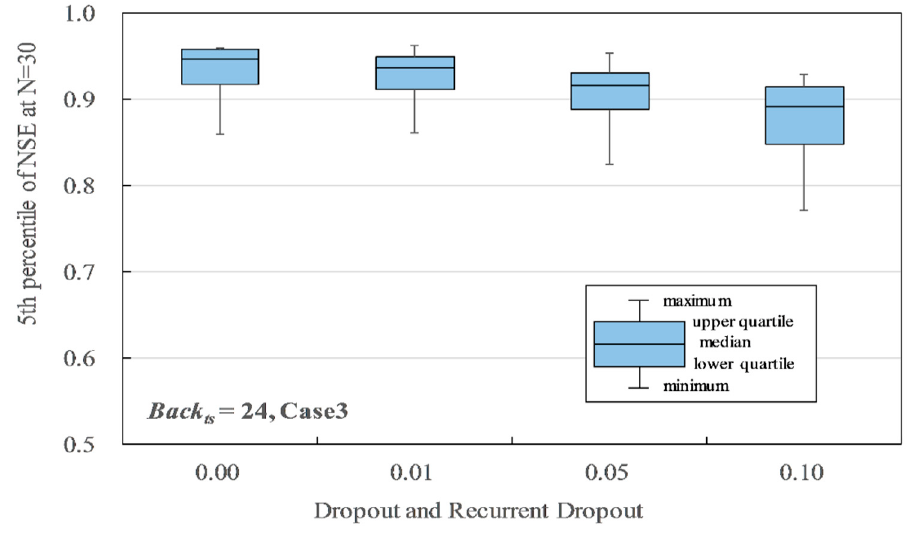
12 of 16 Figure 12. Influence of precipitation on the estimation results. 3.4. Dropout and Recurrent Dropout Figure 13 shows the influence of dropout and recurrent dropout ( Drp & Drp r ), when Hid = 20 to 200 and Back ts = 24 for Case 3. The accuracy improved as Drp & Drp r became smaller, and Drp & Drp r = 0.00 had the best accuracy of 0.917 in the lower quartile P 5 of the NSE. The maximum P 5 of the NSE was 0.961 when Drp & Drp r = 0.01 and Hid = 200. When Hid = 20, the minimums were indicated as 0.860, 0.860, 0.825, and 0.771 for Drp & Drp r = 0.00, 0.01, 0.05, and 0.10, respectively. When Drp & Drp r = 0.00 or 0.01, in the case of Hid > 50, the accuracies were indicated to be more than 0.920, which is over the reference accu- racy. In brief, Drp & Drp r = 0.00 shows the best results. The reason may be that higher Drp and Drp r values drop more units for the linear transformation of the input and recurrent